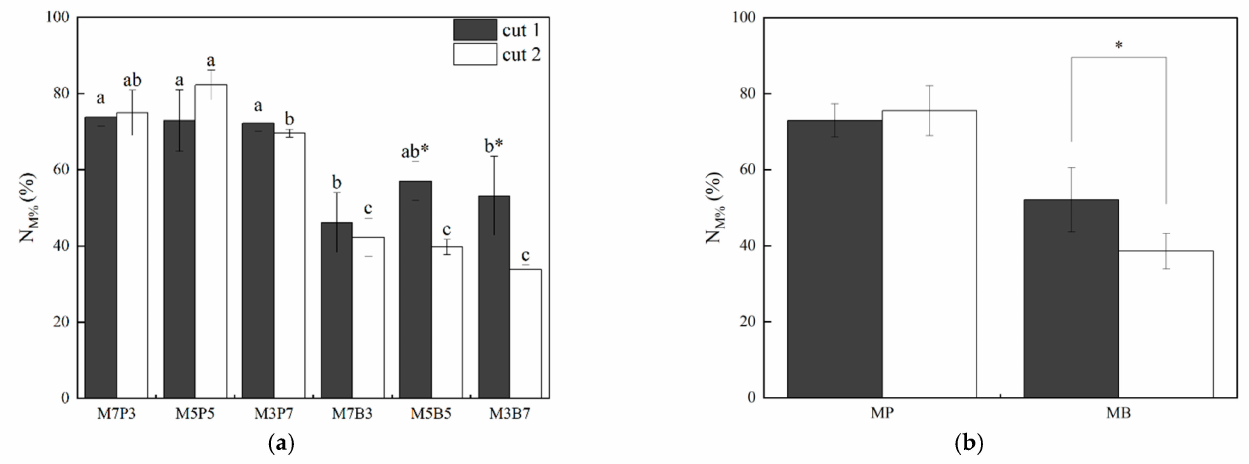
Figure 1. The proportion of lucerne N uptake in total grassland ( a ), (N M% ) in different cuts of mixtures, and ( b ) cut-level N M% under different species combinations. Values are the means ± SD (n = 3 in a and n = 9 in b). Different lowercase letters indicate significant differences ( p < 0.05) among mixtures of the same cut. Asterisks (*) show significant differences between two cuts of the same mixture at p <